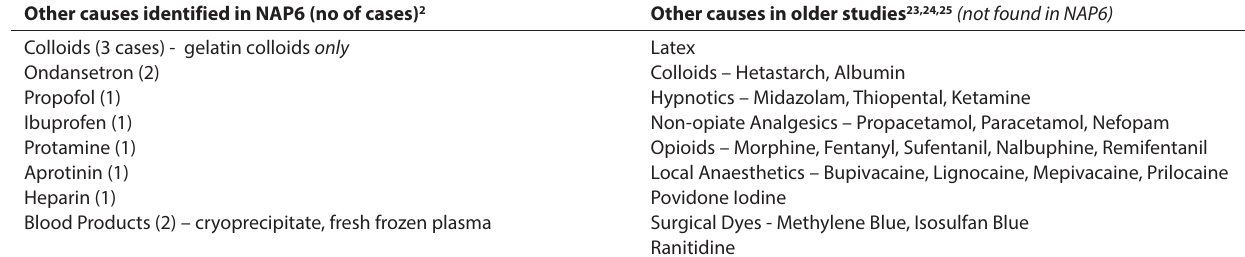
Table 4: Infrequent Perioperative Anaphylaxis Triggers Identified in NAP6 and Other Studies Other causes identified in NAP6 (no of cases)